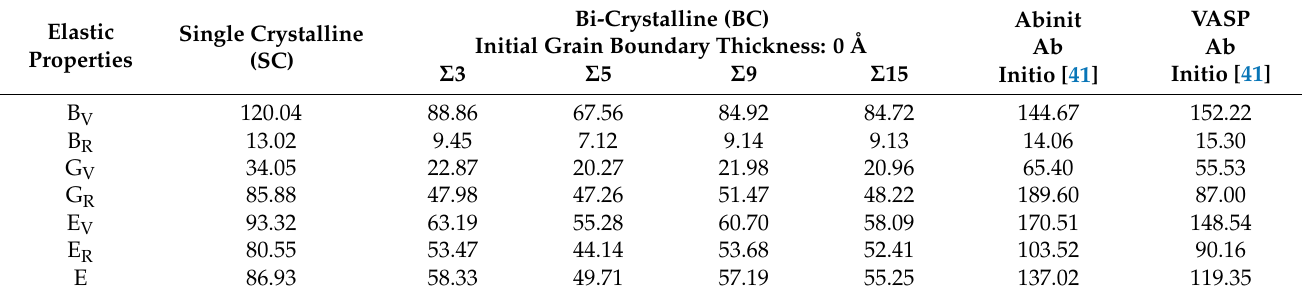
Table 3. Simulation results of elastic properties from different simulations at 200 K. Units in gigapascal (GPa). Elastic Single Crystalline Properties B